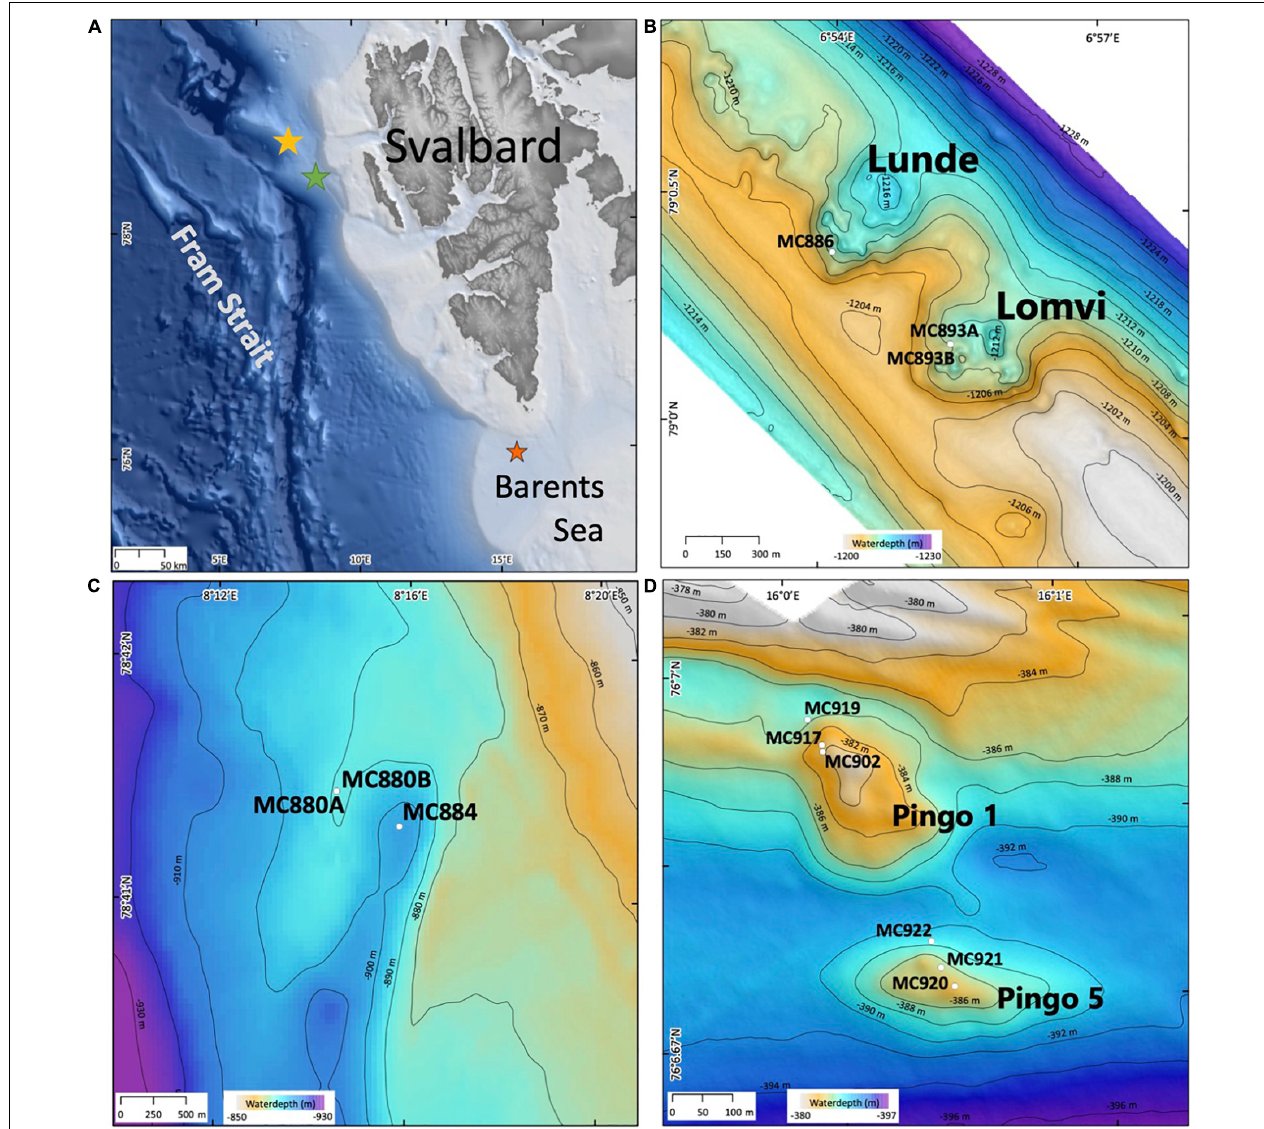
FIGURE 1 | Maps showing (A) sampling location, indicated by stars: yellow- Vestnesa Ridge; green- Control site 7,808; orange- Storfjordrenna pingos; (B) bathymetry of Vestnesa Ridge (swath bathymetry from Hustoft et al., 2009); control site (C) and bathymetry of Storfjordrenna pingos [ (D) ; swath bathymetry from Serov et al.